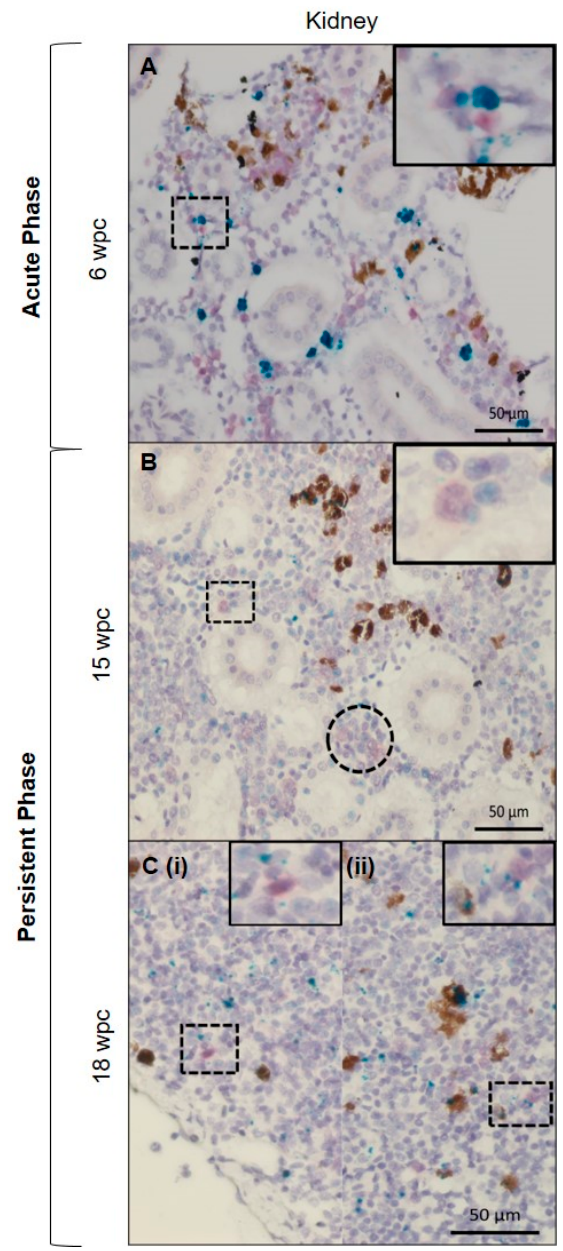
Figure 7. PRV-1 localization in hematopoietic cells. Duplex in situ hybridization against PRV-1 (green) and erythropoietin receptor (EPOR) (red). Kidney ( A ) Acute phase, dually stained PRV / EPOR positive cells in hematopoietic tissue in the magnified picture. ( B , C ) Persistent phase, dually stained EPOR-PRV1 positive cells in hematopoietic tissue scattered around in the kidney (magnified pictures). Cluster of partially stained positive erythroid cells at 15 wpc (dotted circle). The use of red dye in salmon kidney sections in duplex in situ gave di ff use staining of positive cells (no background staining). The di ff use staining was di ff erent from the punctate staining seen in single in situ, or the use of green dye in duplex in situ . Scale bar = 50 µ